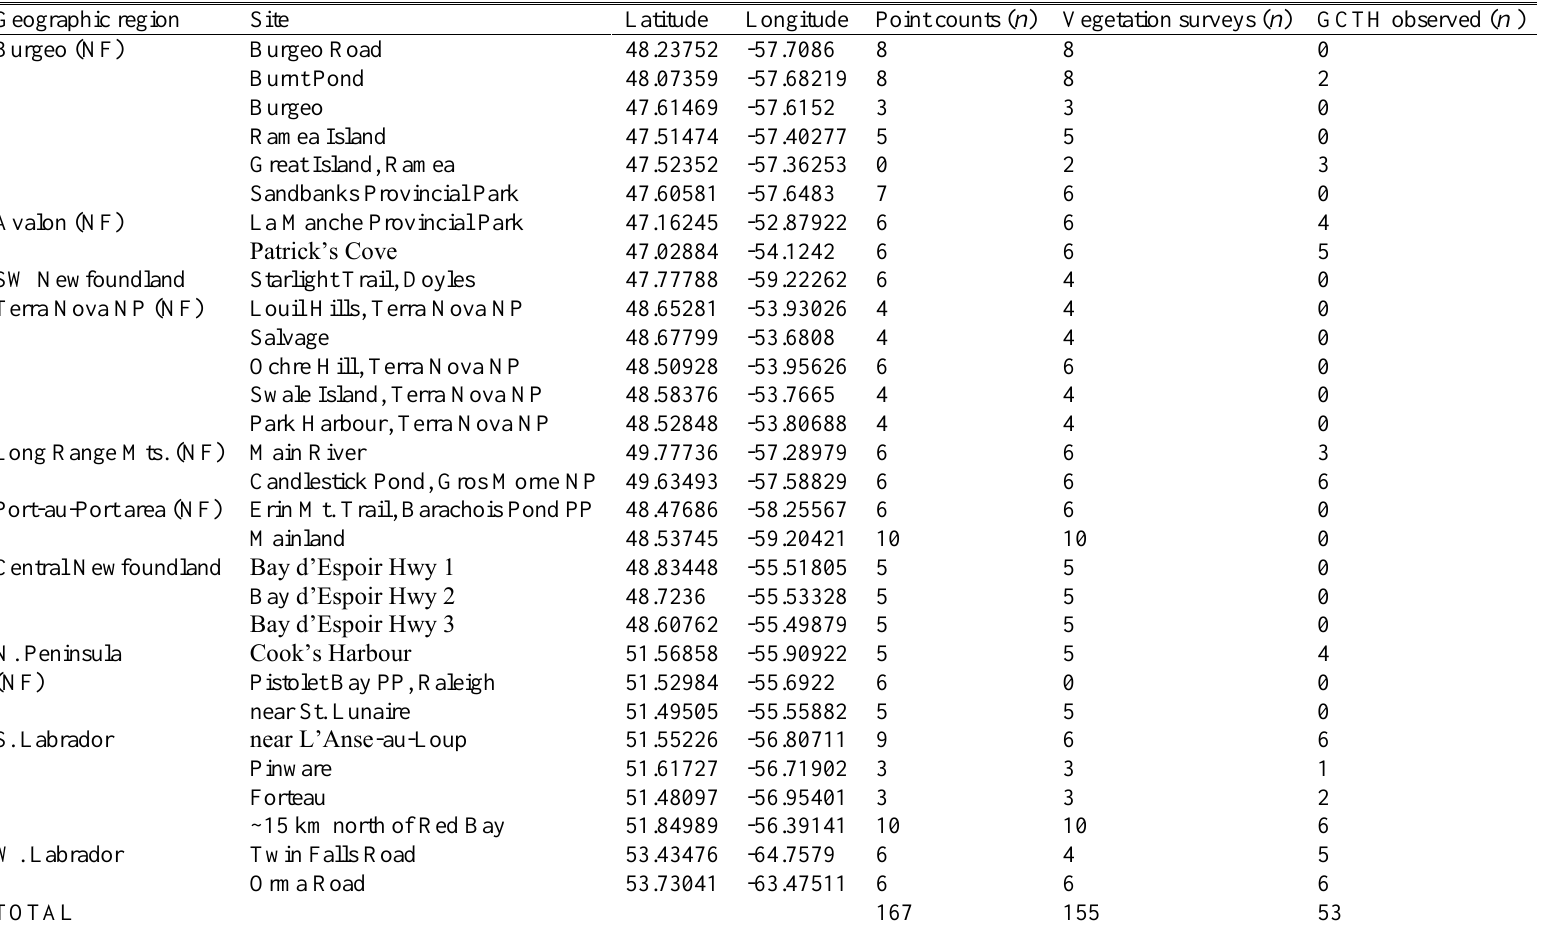
Table A1.2. Summary of Gray-cheeked Thrush ( Catharus minimus ) surveys in Newfoundland and Labrador, Canada (2014-2015). The coordinates show the location of the first point count or, if no point count was conducted, the first vegetation survey. Geographic region